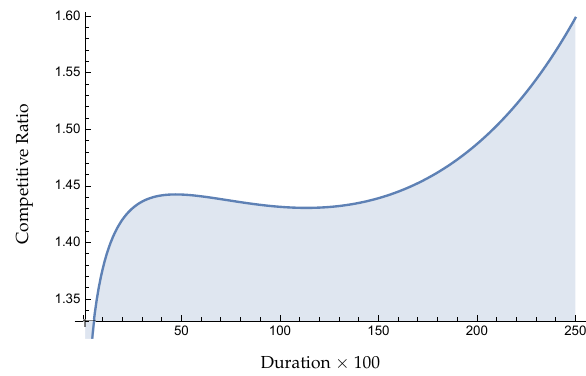
Figure 19. Competitive ratio t = 0.312, z = 0.2.